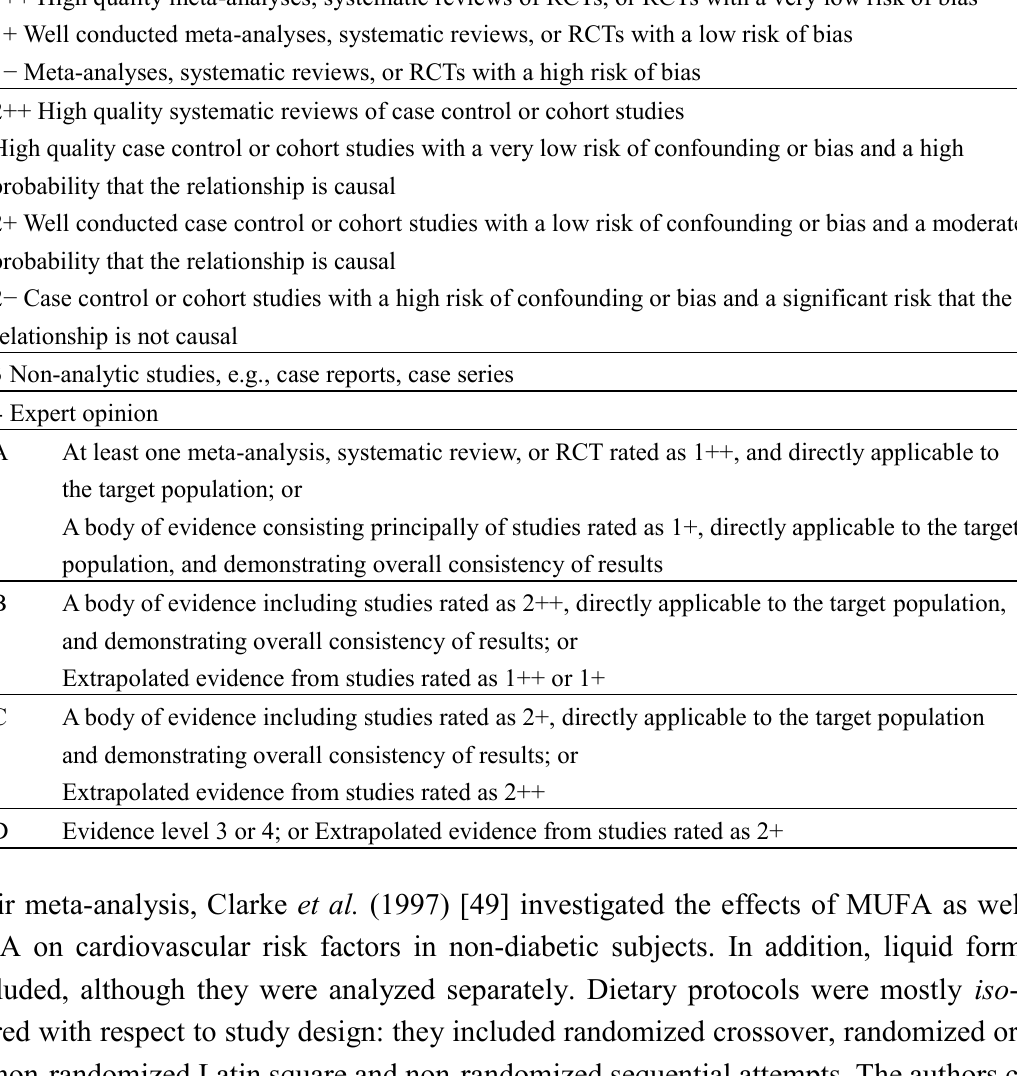
Table 6. Levels of evidence by the Scottish Intercollegiate Guidelines